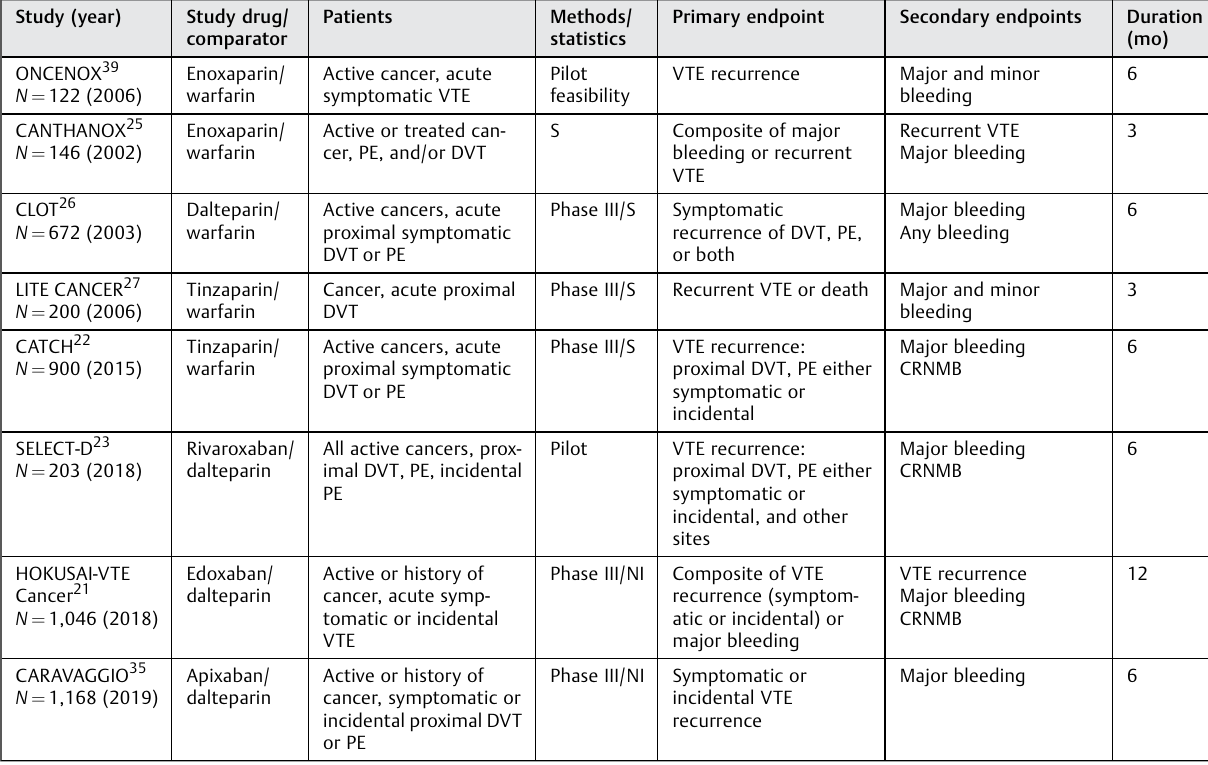
Table 1 Protocol design of randomized control trials on anticoagulants for the treatment of cancer-associated thrombosis Study